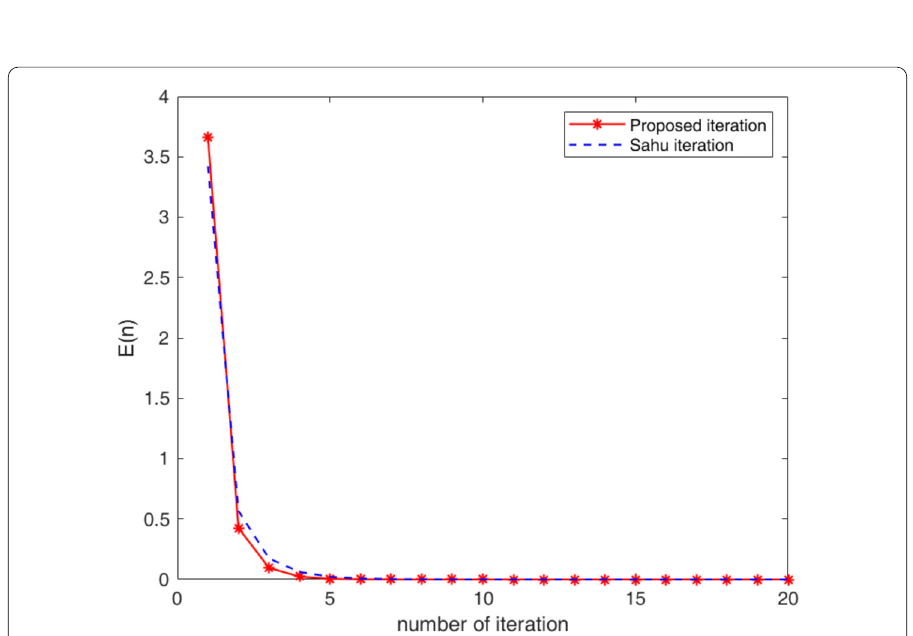
Figure 2 E ( n ) = (cid:16) χ n – χ n +1 (cid:16) for iterations with initial point (3,–1,2)